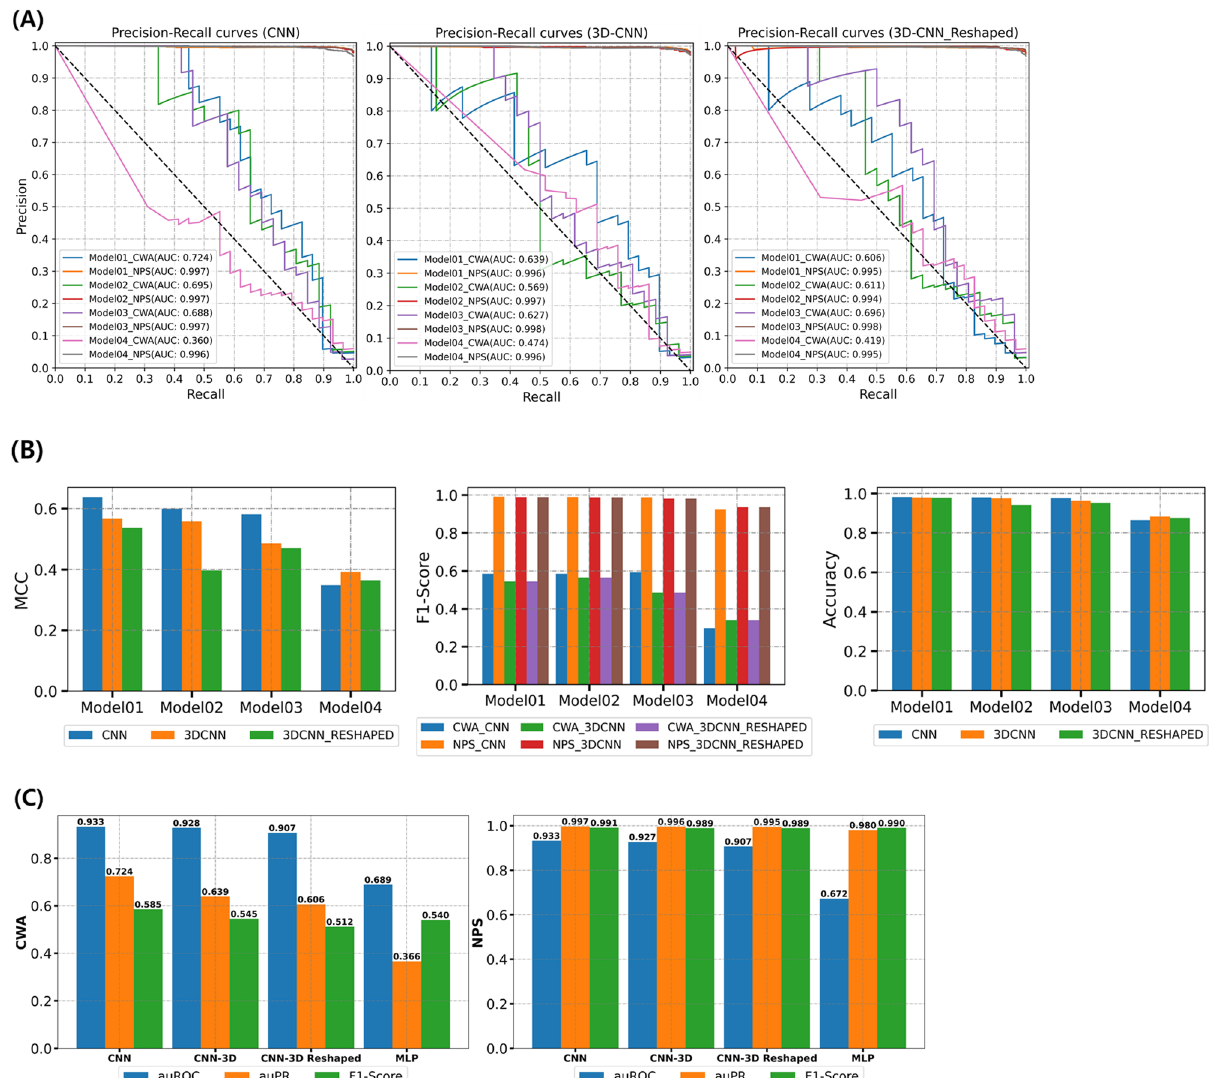
Figure 7. CWD detection performance of the three different shaped array classifiers according to data sampling (Model 01 to 04). ( A ) Precision-Recall curve of CNN models, ( B ) Performance of CNN models (MCC, F1-Score, and Accuracy), and ( C ) comparison with multiple layer perceptron as a baseline model.